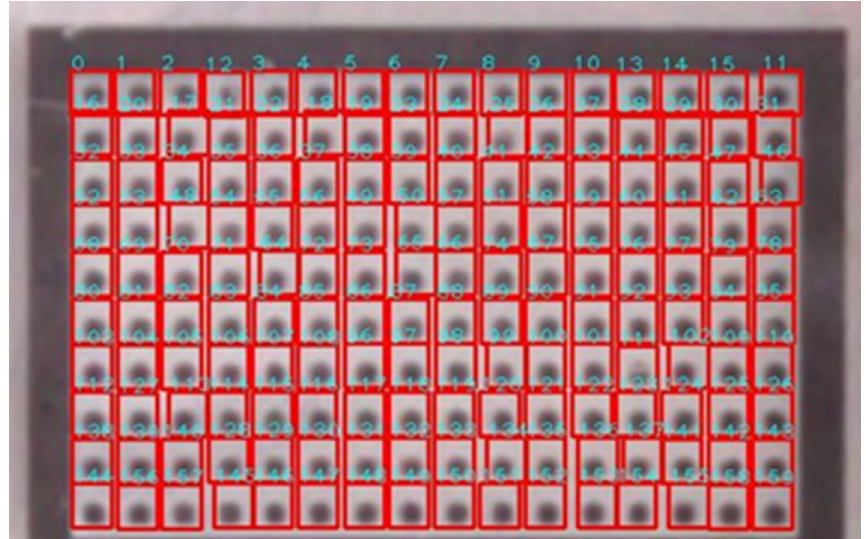
Figure 10. The result of marker recognition. The image is blurred because the Gaussian filter has been applied. A red square indicates that the program recognized that area as a marker. A video of the the measurement video (Video S1) is presented in Supplementary Materials.